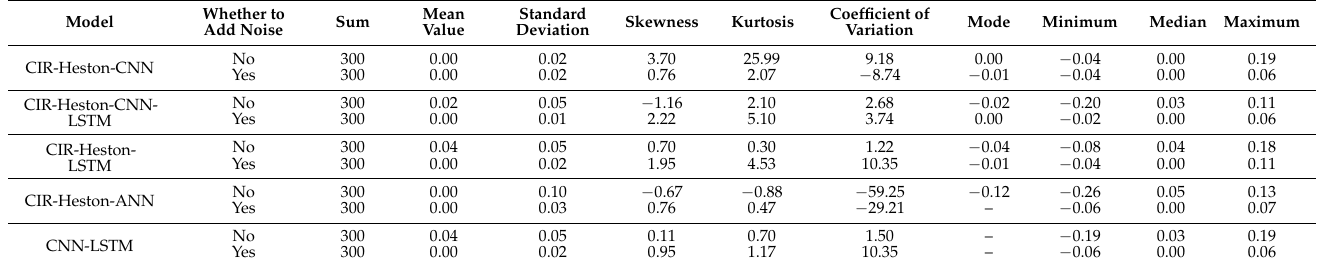
Table 8. Call option model robustness tests for the descriptive statistic.